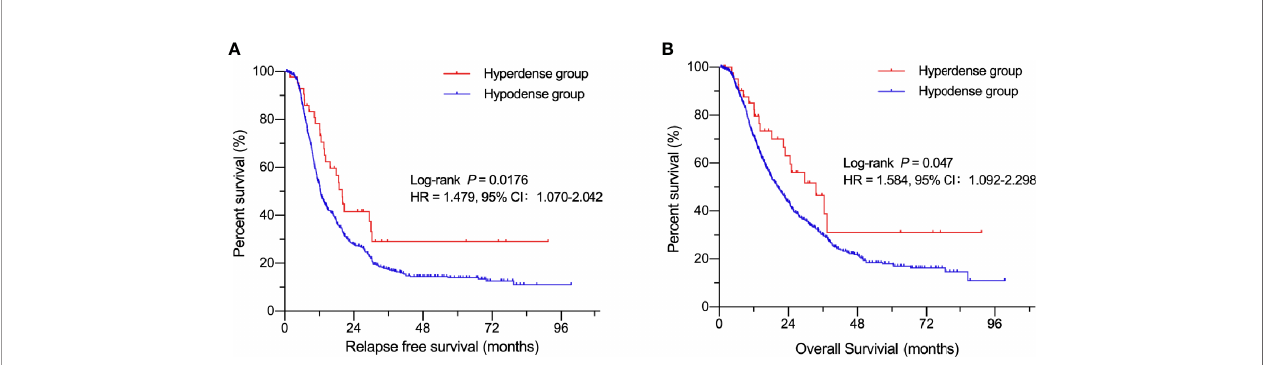
FIGURE 2 | Kaplan-Meier curves of patients in the hyperdense and hypodense groups. (A) Comparison of RFS between the hypo- and hyperdense groups. (B) Comparison of OS between the hypo- and hyperdense